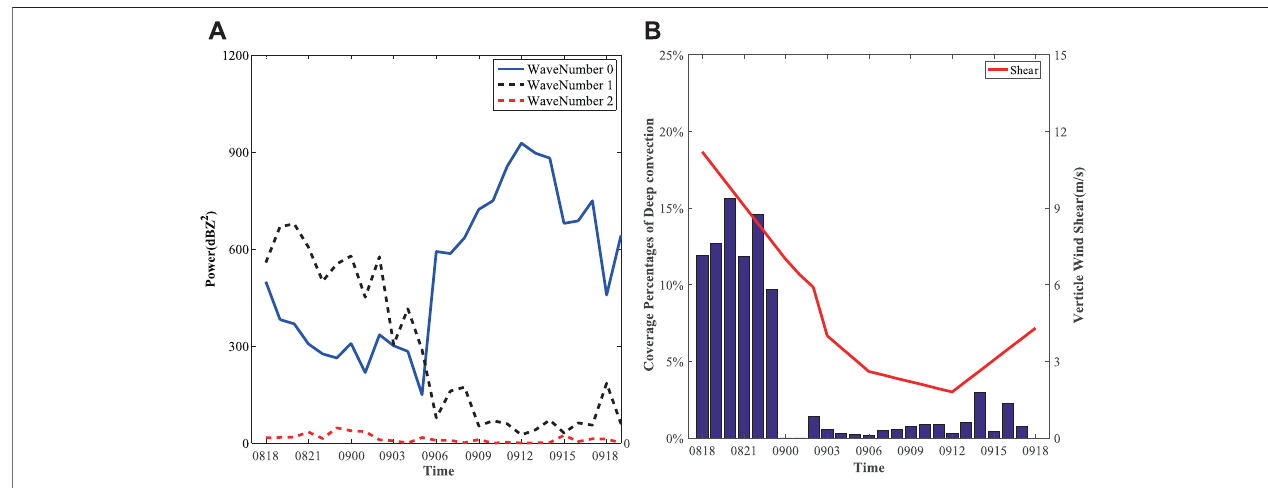
FIGURE3| Timeevolutioncharacteristics ofwavenumberenergy (A) oftheechonearthemaximumwindspeedradius,andareapercentageofstrongconvection in the core area overlying with vertical wind shear (B) .